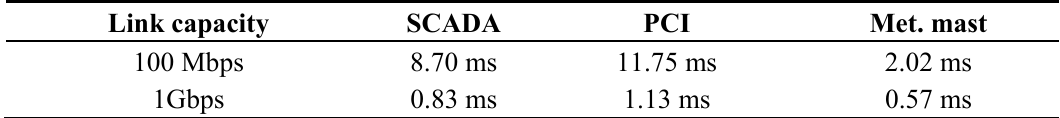
Table 9. Average ETE delay for small-scale WPF.